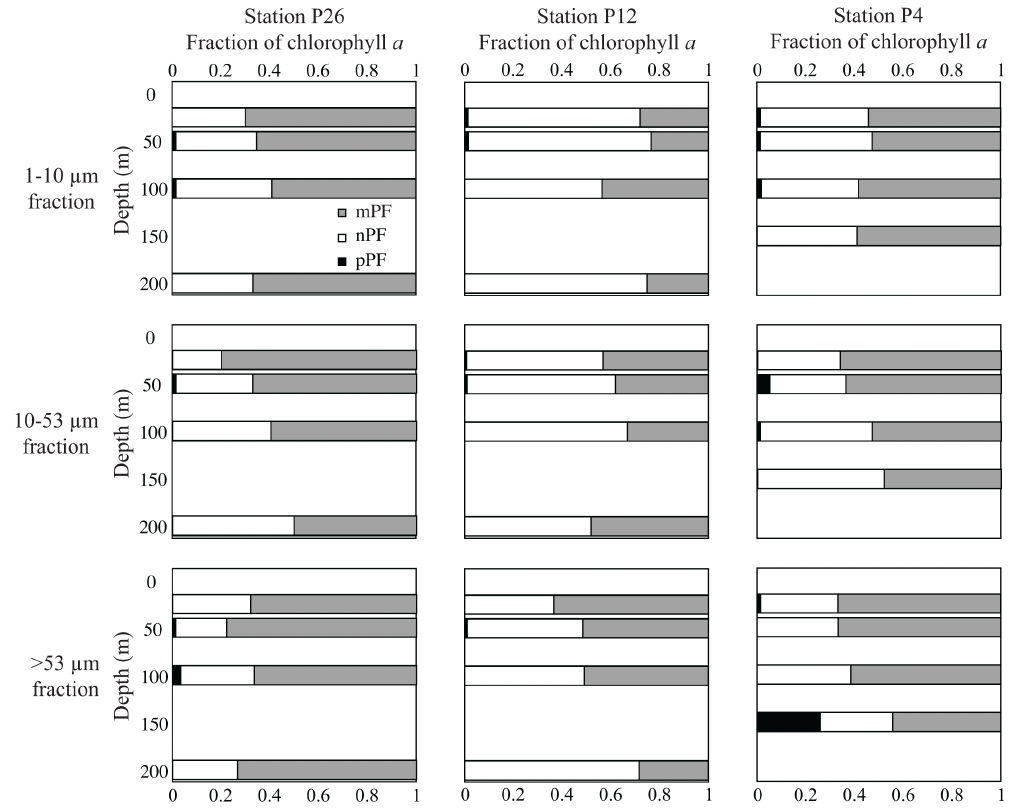
Figure 7. Pigment PFs for each phytoplankton size class plotted as a function of sample depth and particle size class at stations sampled on Line P in February 2012. Size-fractionated data are pump data. Table 5. 234 Th and POC fluxes and POC / 234 Th ratios measured by the PITS